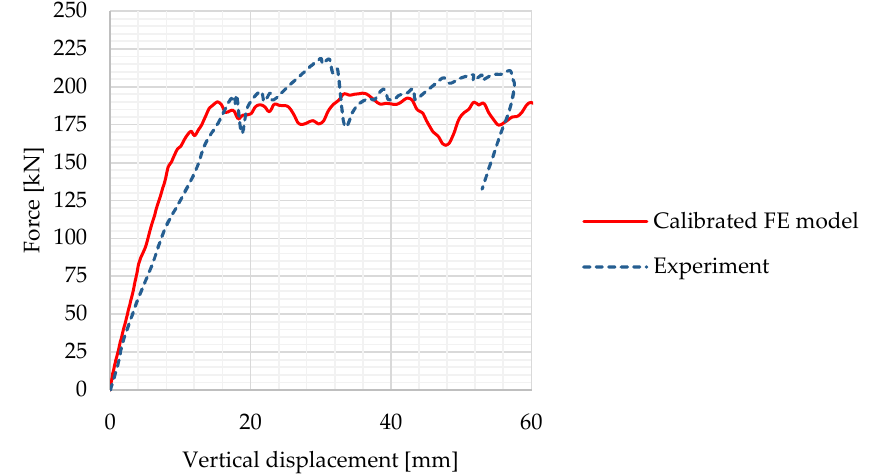
Figure 16. Force–displacement curves for the calibrated FE model and the experiment.